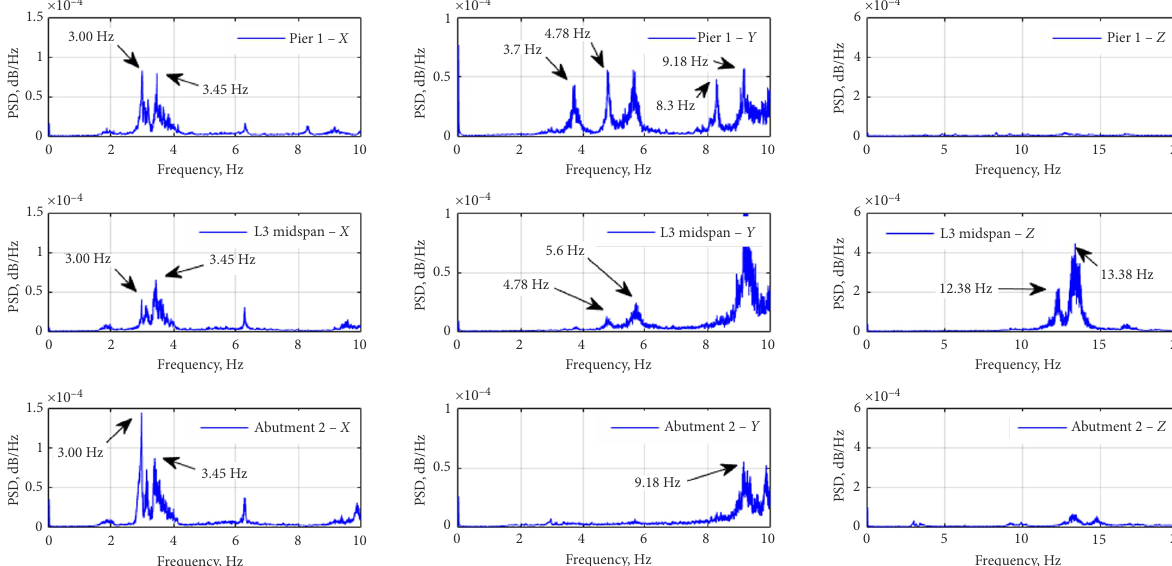
Figure 14. Frequency domain presentation of the signals for the third set of measurements in the second Ambient Vibration Survey